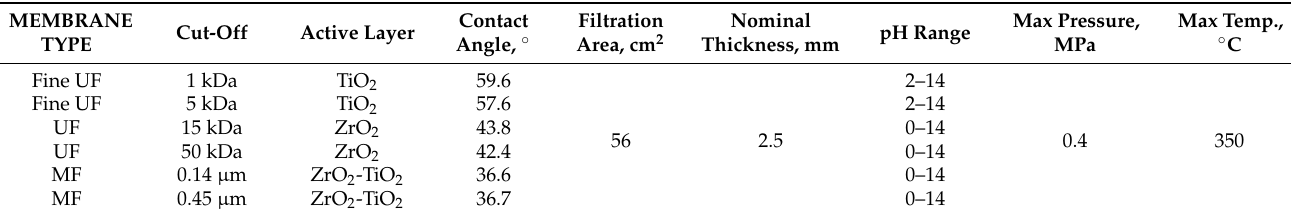
Table 1. Characteristics of flat ceramic membranes used for membrane filtration (compiled on the basis of [39] and our own research).